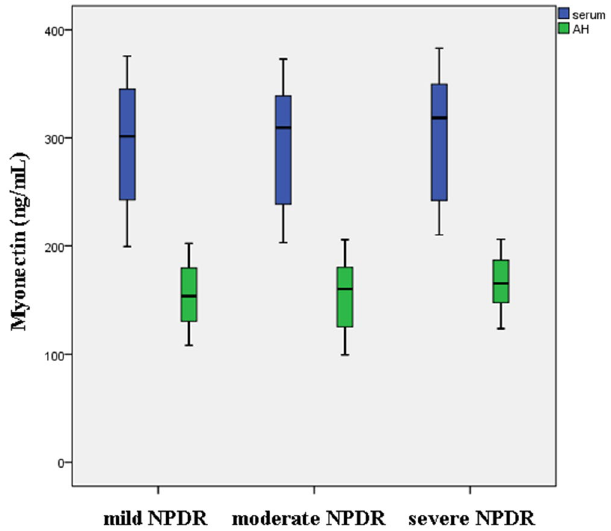
Figure 1. Serum and aqueous humor myonectin concentrations in mild, moderate, and severe NPDR subgroups. No difference of serum and aqueous humor myonectin concentrations were found between the three subgroups.